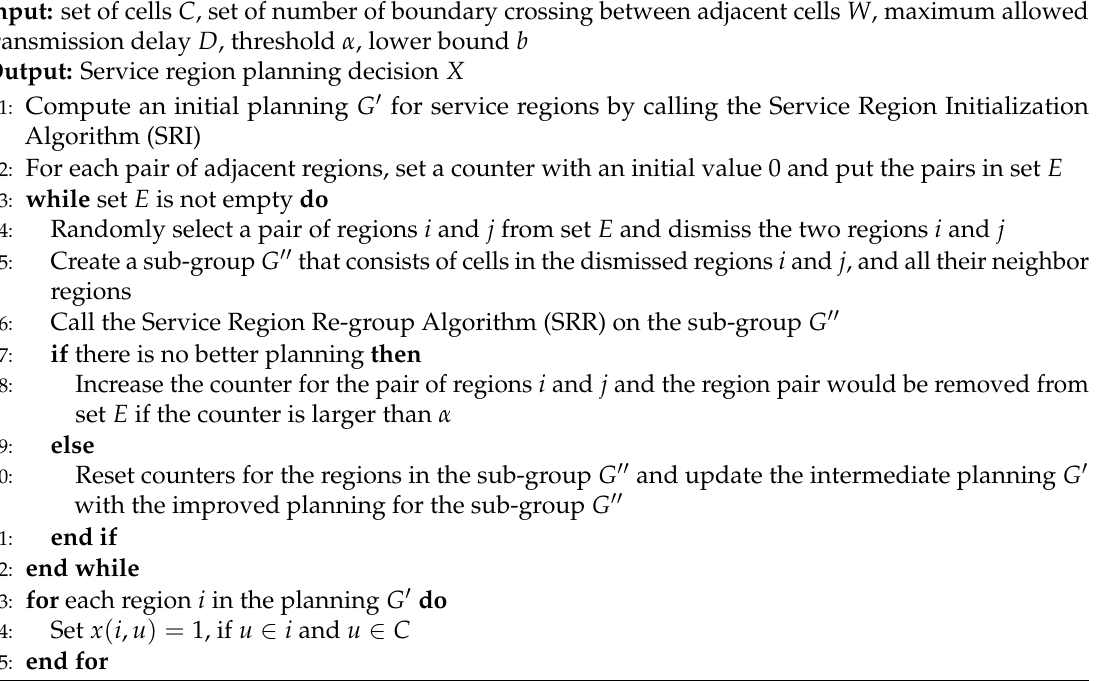
Algorithm 1 Service Region Planning Algorithm